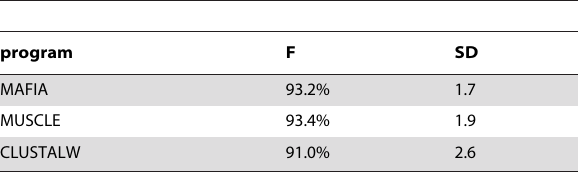
Table 1. Alignment accuracy for PSPE simulation runs, averaged across runs (CRMs).